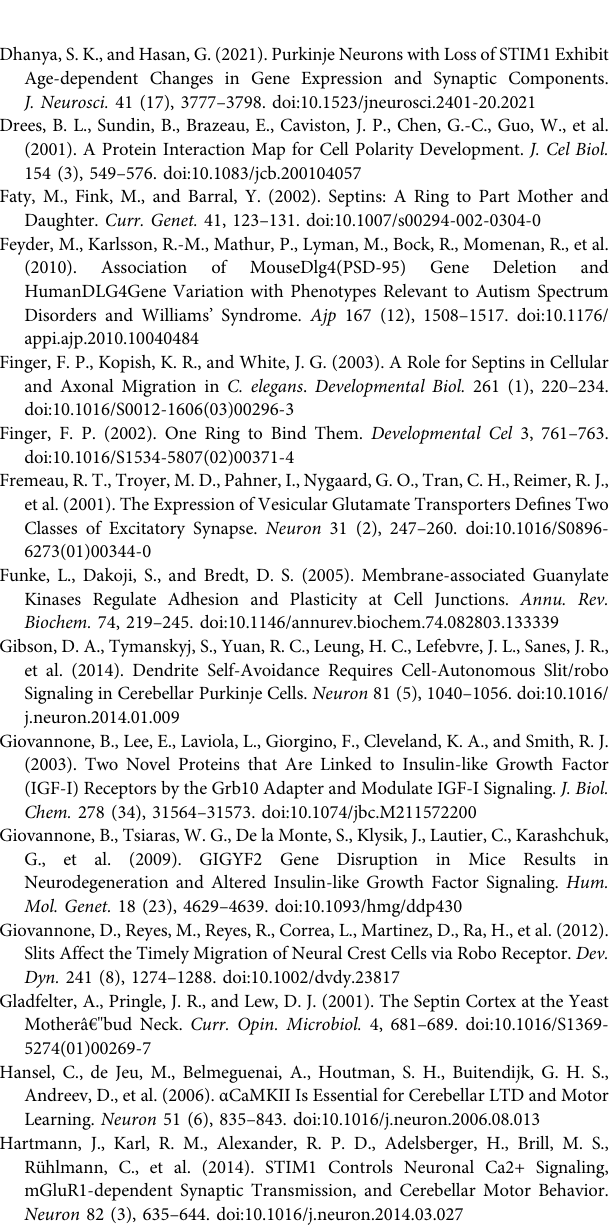
protein 1; Syt11 , synaptotagmin 11, Setd6 , SET domaincontaining 6, Gapdh , glyceraldehyde 3-phosphate dehydrogenase. Supplementary Figure S2 | Experimental setup of rotarod assay with mice of various genotypes of SEPT7 – STIM1 mutant strain (Related to Figure 5 ) Snapshots of mice of indicated genotypes on an accelerated rotarod at 0, 45, and 102 s. Lane 1 – STIM1 fl ox/ fl ox ; SEPT7 fl ox/ fl ox (wild), Lane 2 – STIM1 PKO , Lane 3 – STIM1 PKO , Lane 4 – STIM1 PKO ; SEPT7 PHet , Lane 5 – STIM1 PKO ; SEPT7 PKO . All animals were aged 6 months. Mice that have fallen from the accelerating rod are indicated by red arrows. Supplementary Video S1 | Rotarod assay of SEPT7 – STIM1 mutant mice strain (related to Figure 5 ). Video of the rotarod assay with mice of indicated genotypes. Lane 1: STIM1 fl ox/ fl ox ; SEPT7 fl ox/ fl ox (wild), Lane 2: STIM1 PKO , Lane 3: STIM1 PKO , Lane 4: STIM1 PKO ; SEPT7 PHet , Lane 5: STIM1 PKO ; SEPT7 PKO . All mice were 6 months old in this